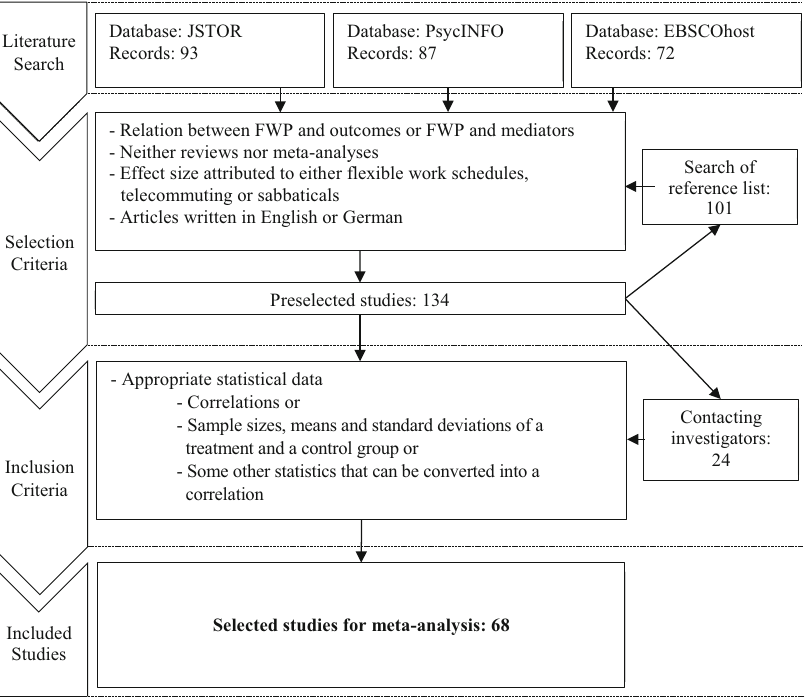
Fig. 2 Schematic diagram of literature research and